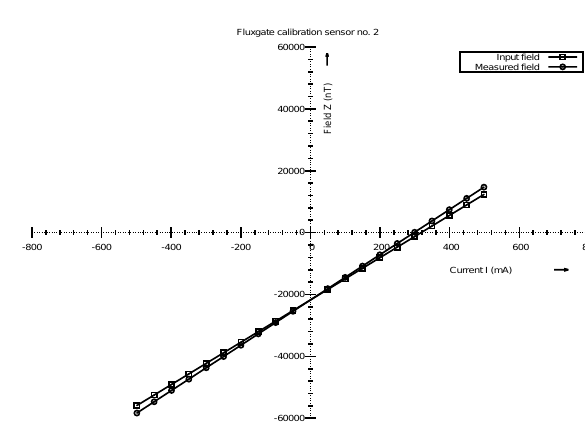
Figure 14. Fluxgate calibration using a z coil (sensor no.